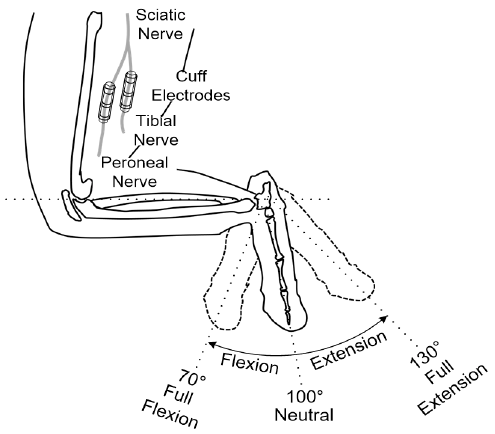
Figure 8. Implantation sites of the cuff electrodes and definition of the ankle joint angles.